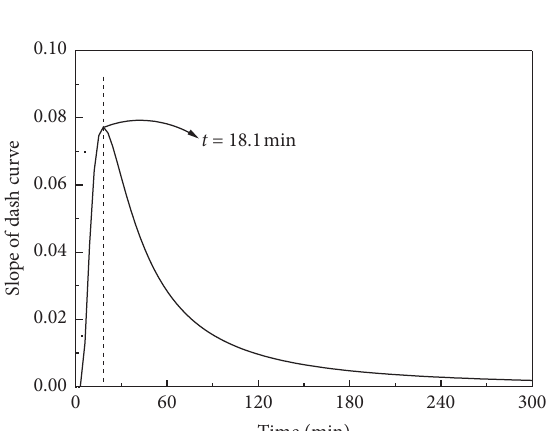
Figure 3: Variation of swelling strain with time.